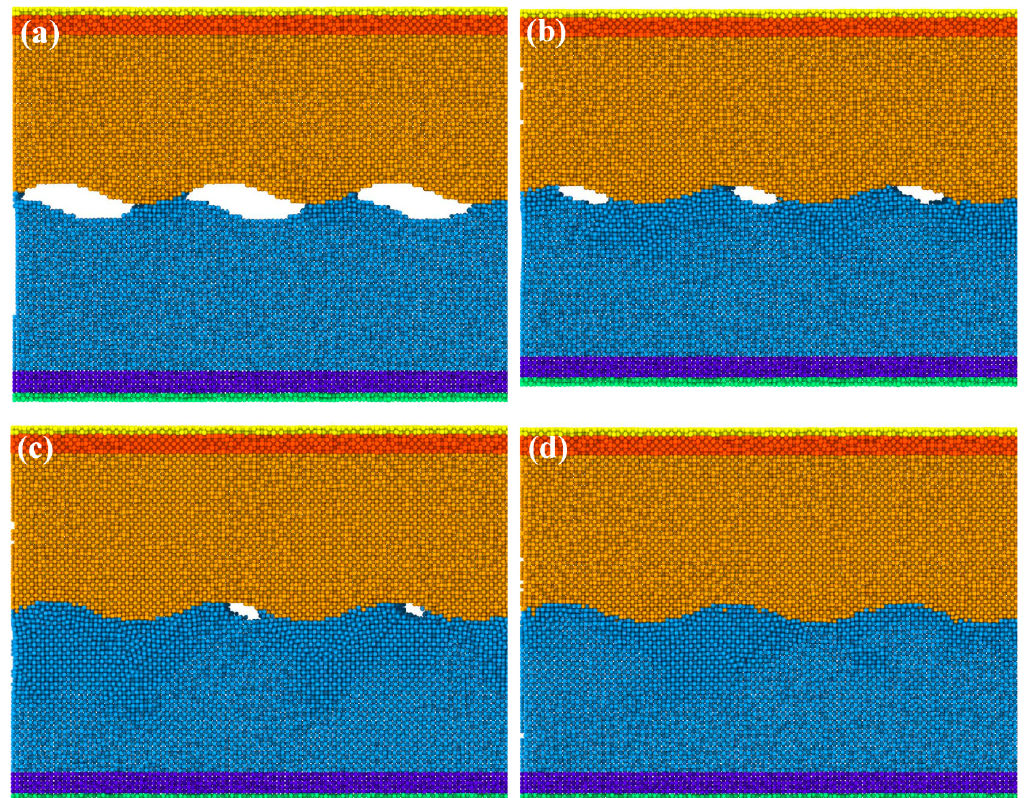
Figure 2. Configurations of the interfacial deformation process during the compression stage at: ( a ) 20 ps, ( b ) 40 ps, ( c ) 60 ps, and ( d ) 120